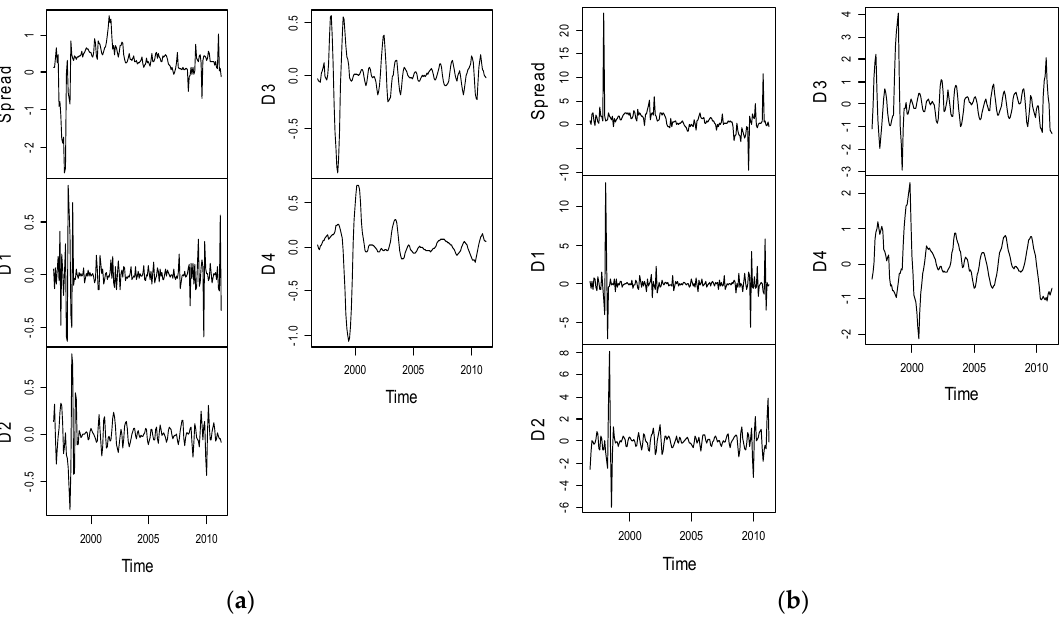
Figure A2. Plot of yield spreads constructed at the policy relevant area of yield curve and their corresponding wavelet decompositions. ( a ) Sp (5, 3); ( b ) Sp (10, 3).